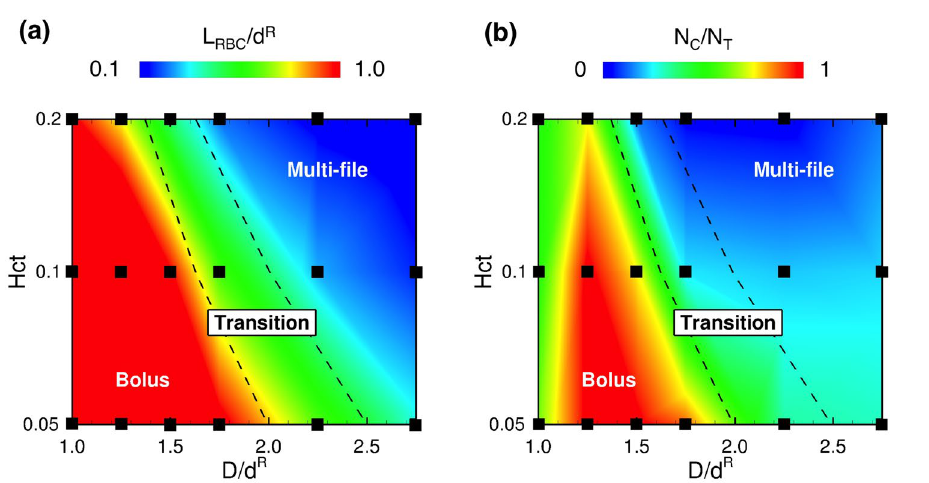
Figure 5. ( a ) Average distance between two RBCs normalized by the diameter of RBCs, L RBC / d R , and ( b ) capture ratio as functions of D / d R and Hct . “Transition” refers to a state that bolus flow and multi-file flow coexists in a